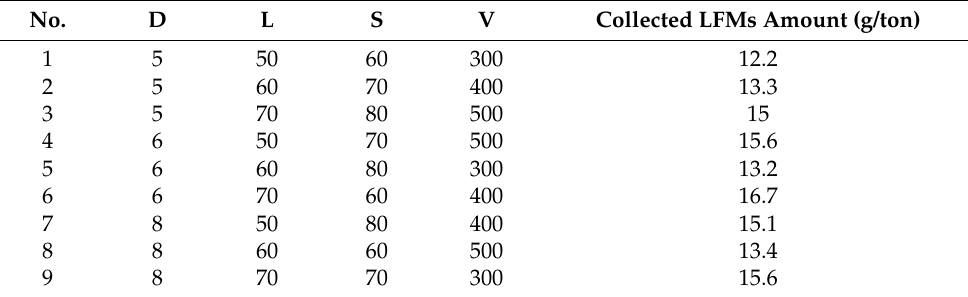
Table 3. Scheme and results of orthogonal